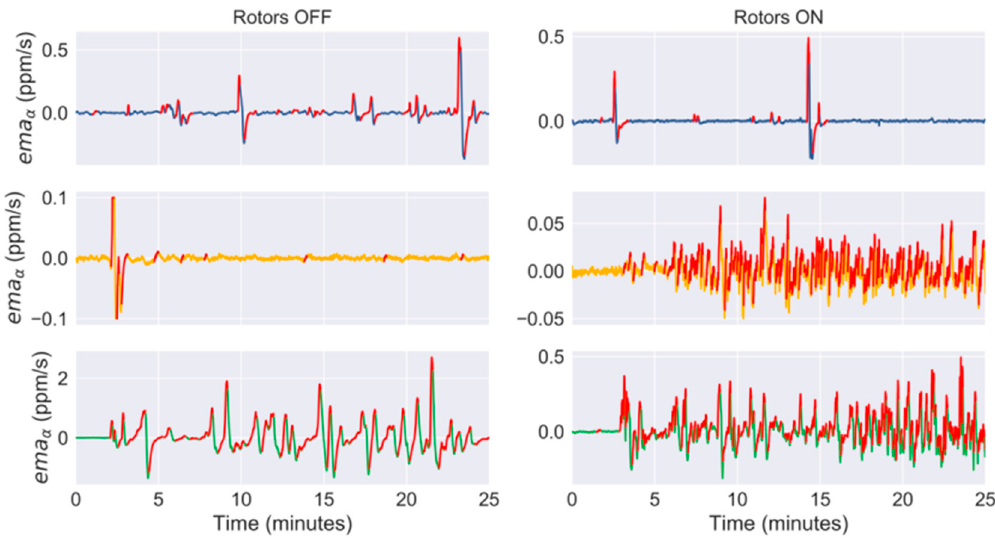
Figure 13. Smoothed derivative (i.e., x (cid:48) s in Figure 7) of the sensor signals at 50 cm in front of the source (blue line), 65 cm above the source (yellow line) and 25 cm above the source (green line). Bouts with amplitude higher than µ + 3 σ are highlighted in red. In the left column, the propellers are switched off whereas in the right column they are switched on. The ethanol bottle is opened at t = 2 min. Table 1. Characterization of MOX signals at different distances of the source under two conditions: propellers switched on or off.